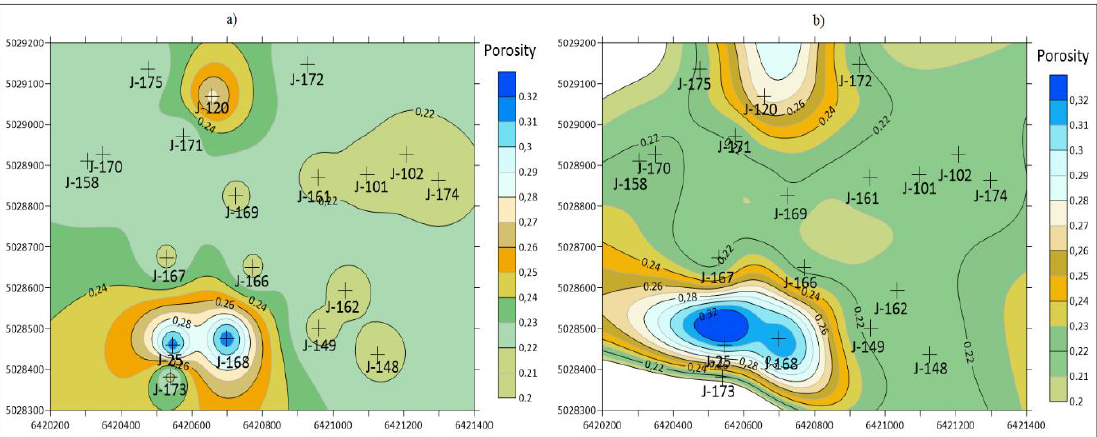
Figure 8. Porosity of reservoir "K": ( a ) IDW; ( b ) MSM.